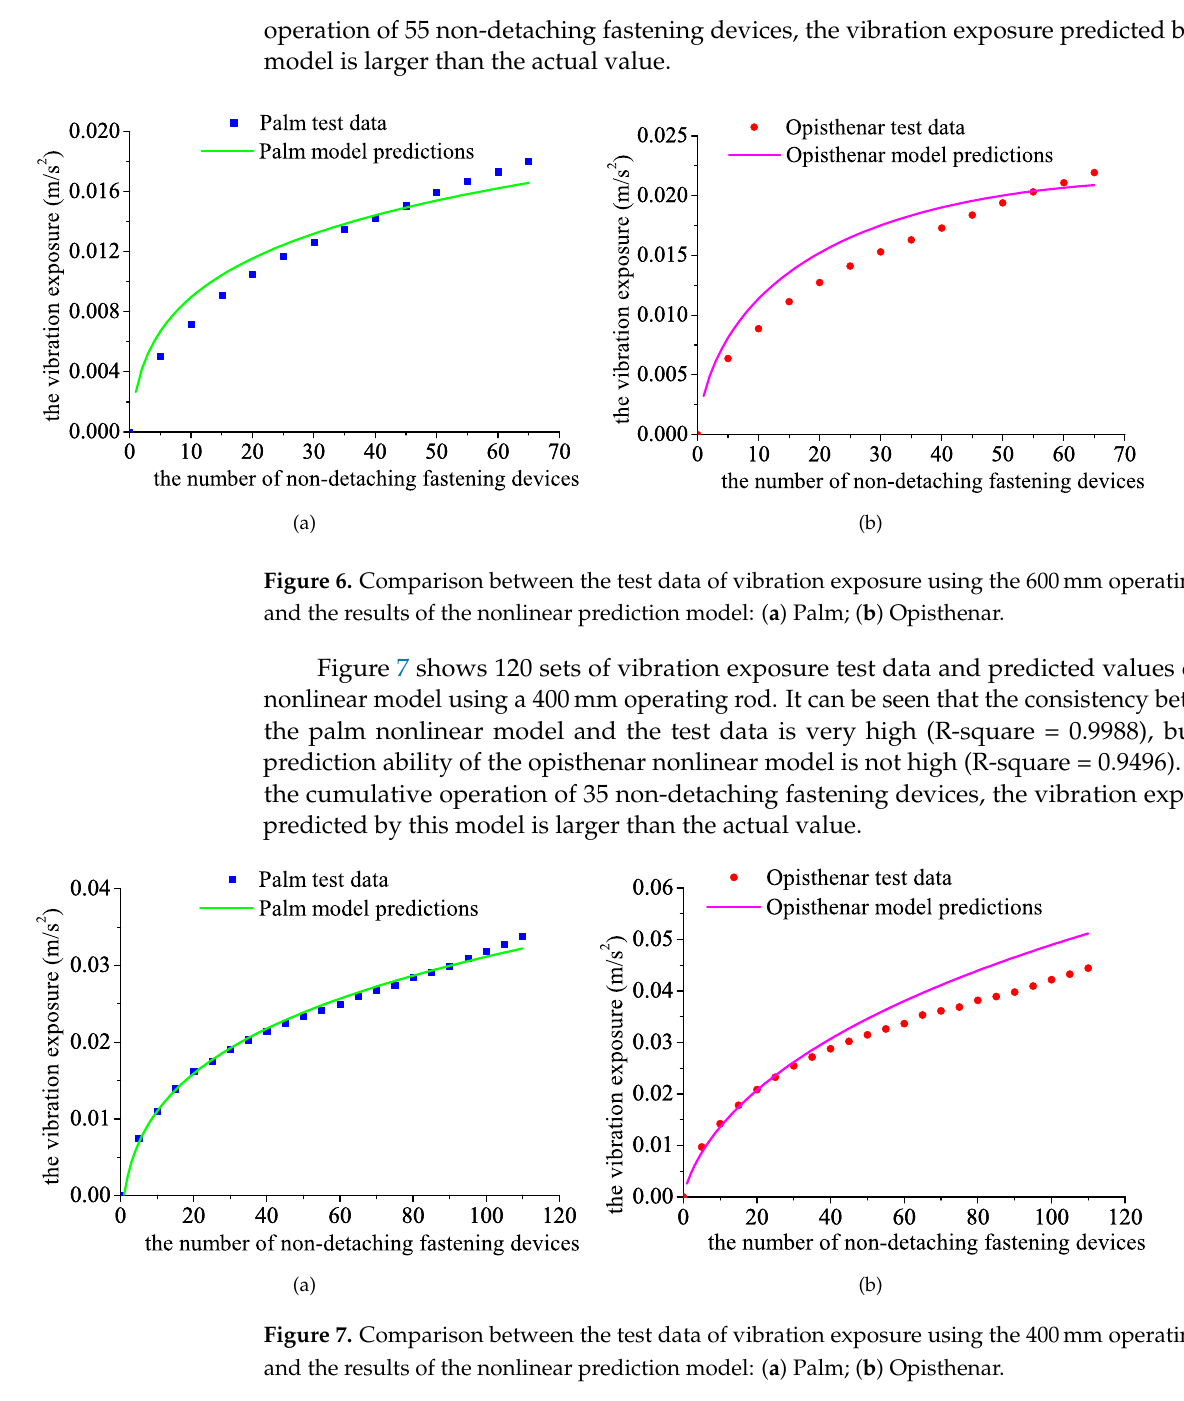
Figure 7. Comparison between the test data of vibration exposure using the 400mm operating rod and the results of the nonlinear prediction model: ( a ) Palm; ( b )